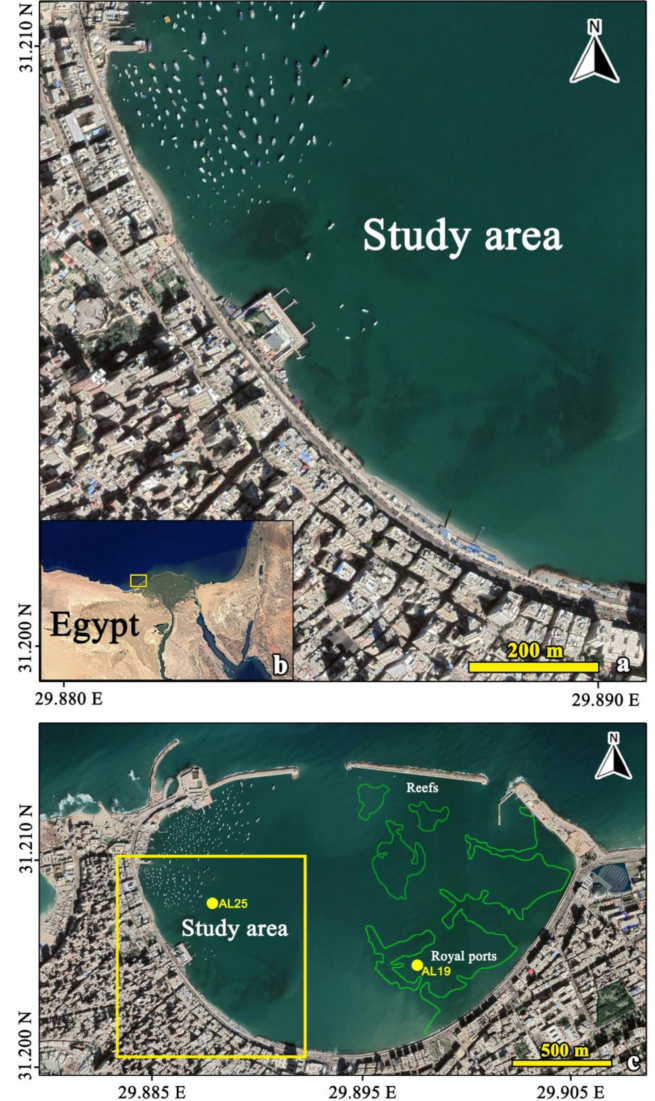
Figure 1. ( a ) Map of the study area in front of Egyptian Sea Scout Club; ( b ) map of the northern part of Egypt; ( c ) map of the Eastern harbor of Alexandria showing the previously detected structures, represented by the light green polygons (after Goddio et al., 1998 [1]); core samples locations are marked by yellow circles (after Stanley et al., 2007